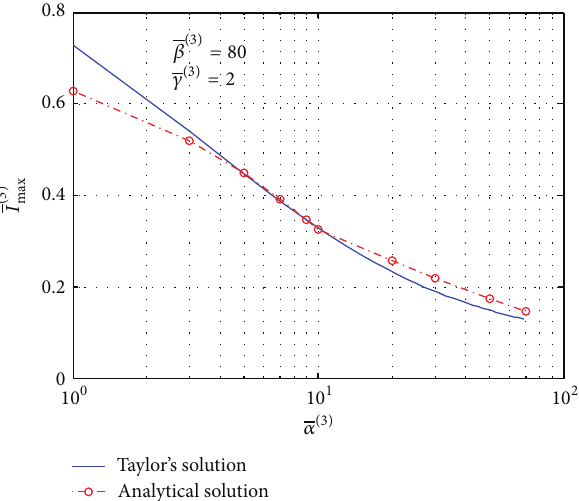
(3) max to the normalized parameter